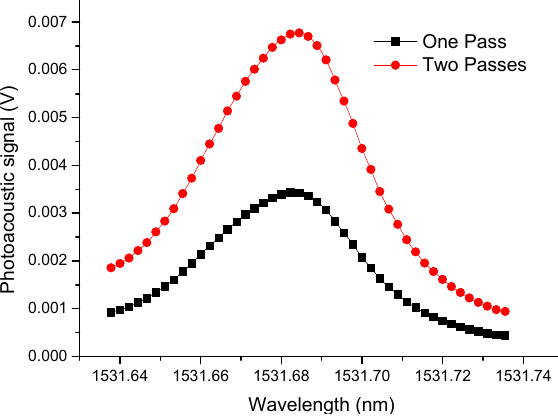
Figure 7. Photoacoustic signal at one optical beam pass (Black line) and two passes (red line).